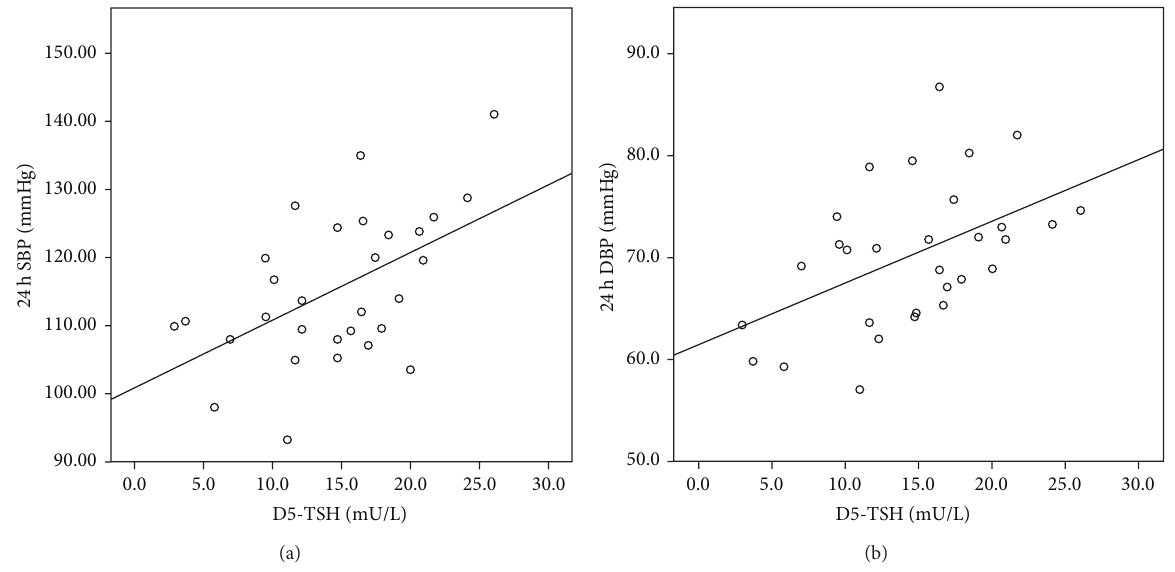
Figure 1: Correlation of 24 h SBP and 24 h DBP with D5-TSH levels in female patients undergoing rhTSH stimulation test. Table 2: Partial correlations of D5-TSH with arterial pressure measurements when various confounding factors were taken into